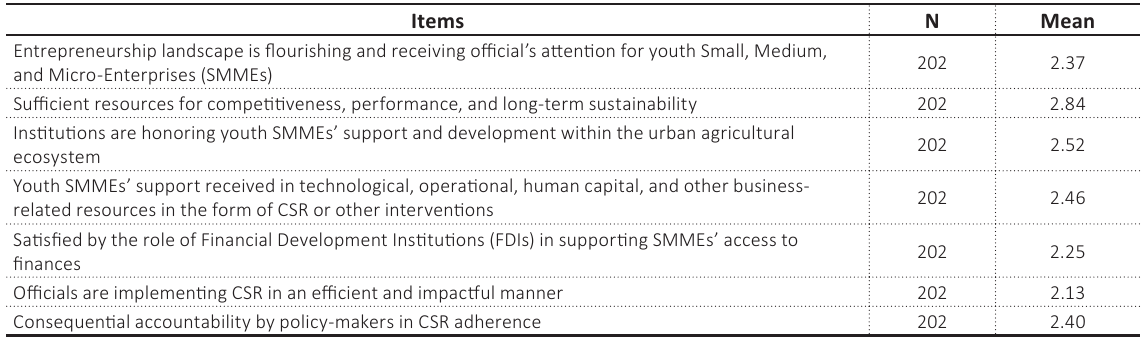
Table 3. Descriptive